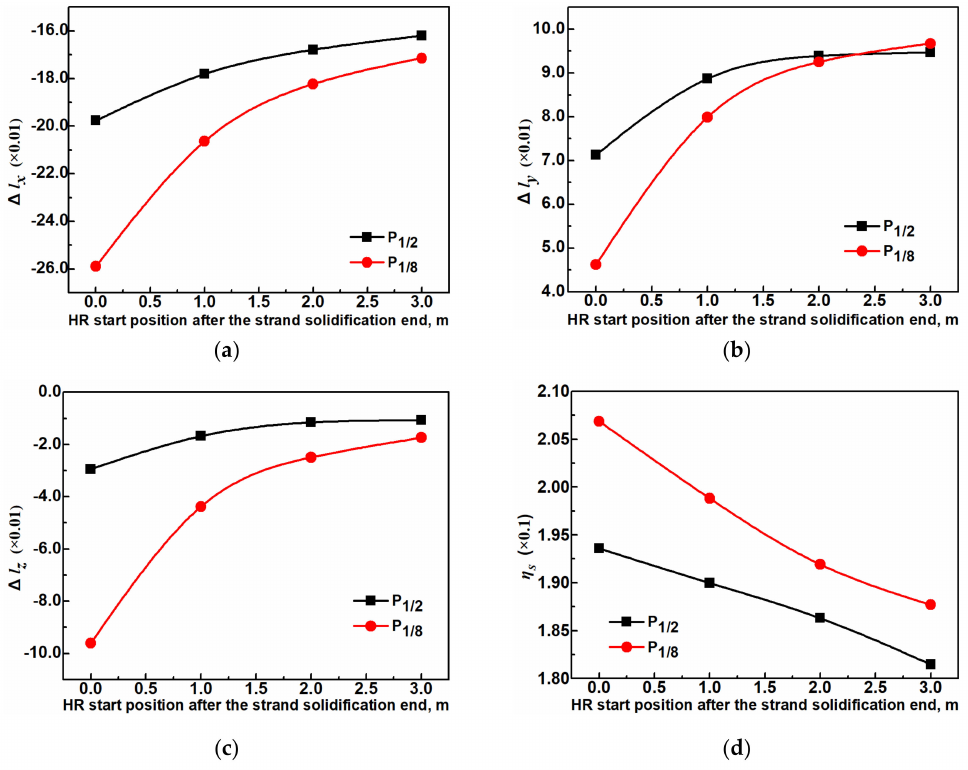
Figure 14. Porosity deformation degree along the ( a ) slab thickness direction, ( b ) casting direction, ( c ) slab width direction, and ( d ) the porosity closure degree after 6% HR deformation implemented at different strand position.